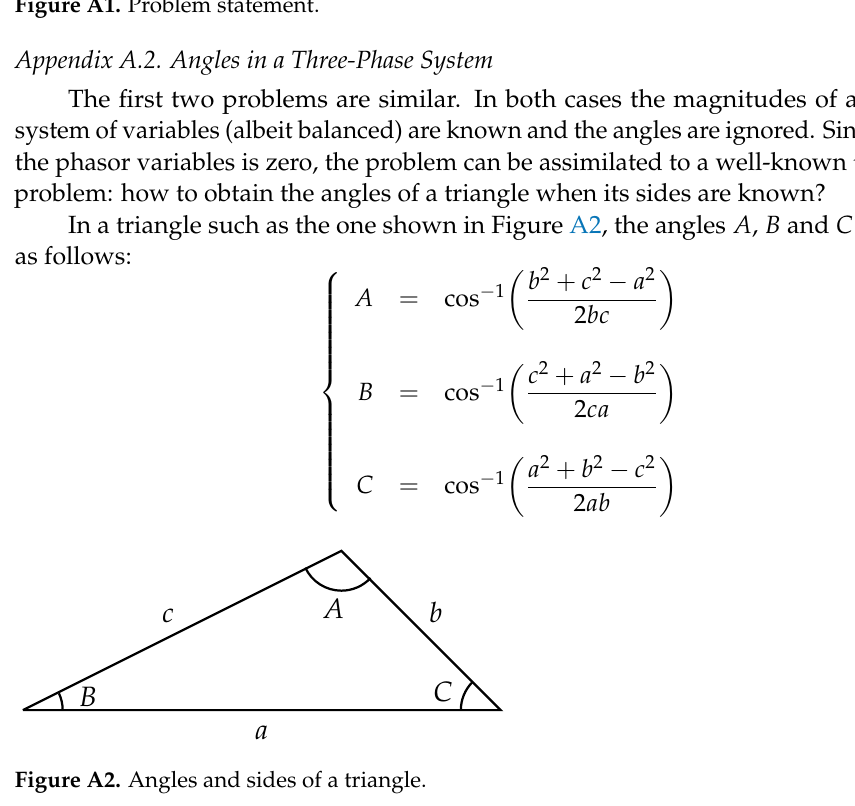
Figure A2. Angles and sides of a triangle